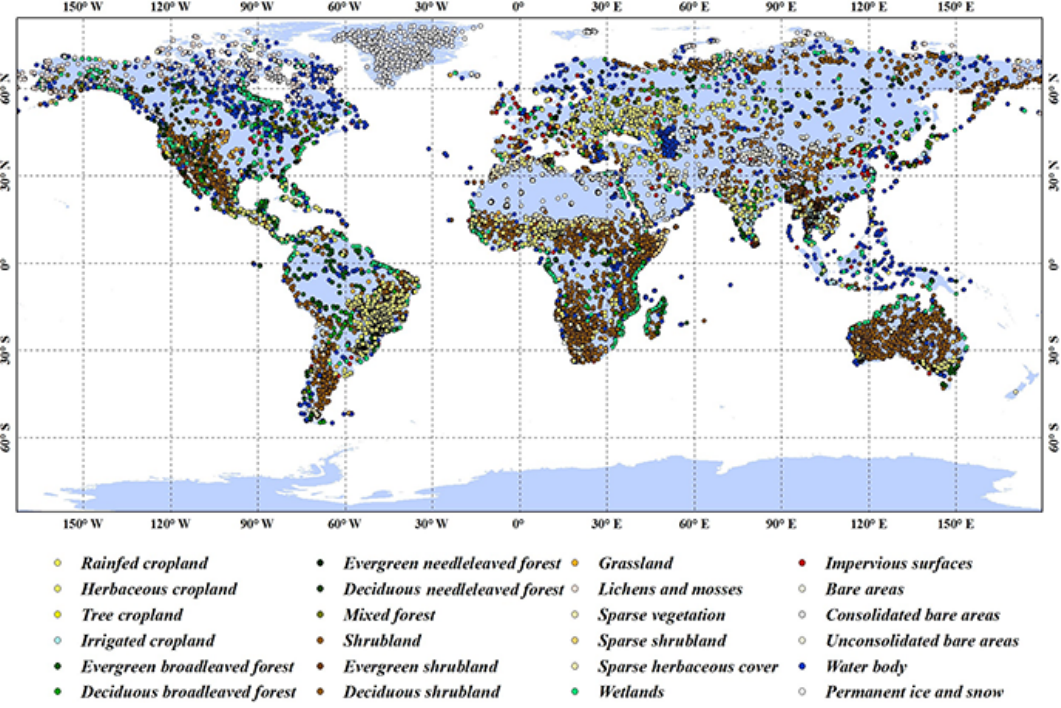
Figure 2. The spatial distribution of the global validation